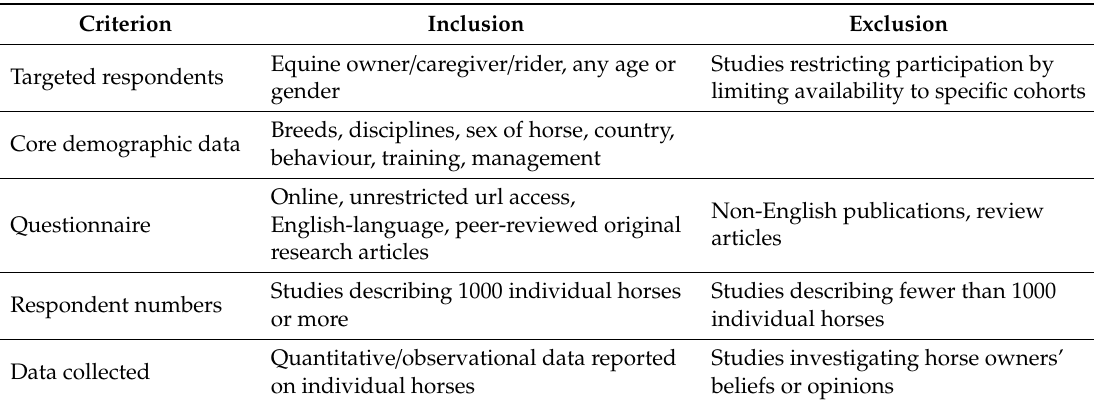
Table 1. Inclusion and exclusion criteria used for the literature review investigating the use of online surveys for data collection on horse training, management, and